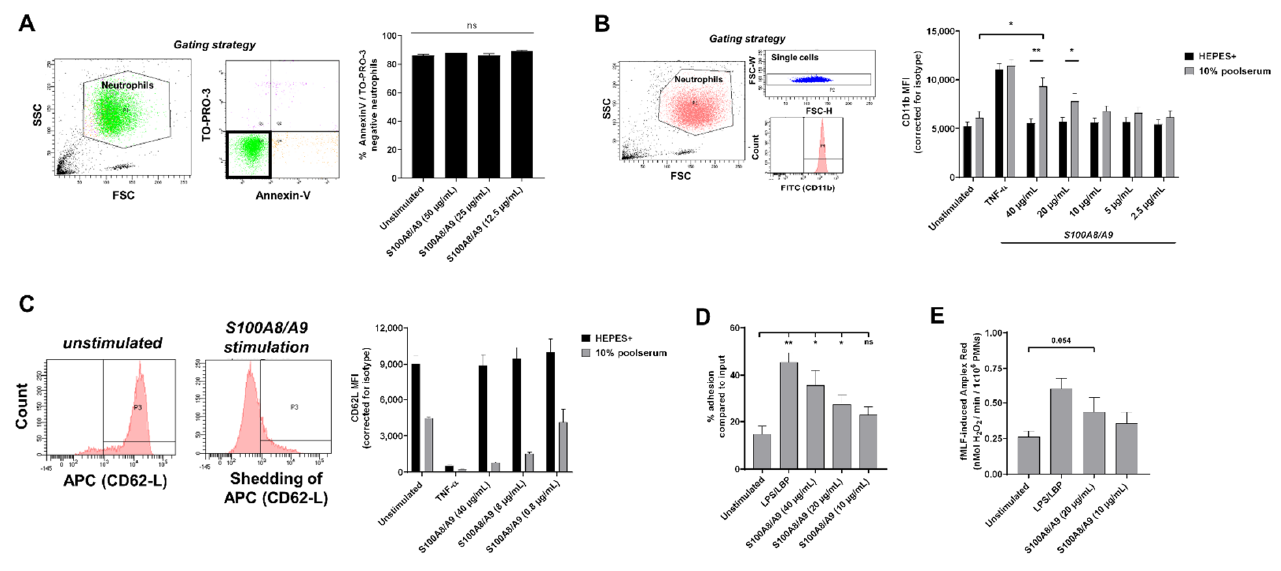
Figure 4. S100A8/A9 activates neutrophils. ( A ) Viability of neutrophils upon 2 h of incubation at 37 °C with S100A8/A9 was assessed by flow cytometry for AnnexinV and TO-PRO. Viable neutrophils were defined as negative for both markers (n = 3, mean + SEM). Indicated in the left panel is the gating strategy. ( B , C ) Expression of neutrophil activation markers ( B ) CD11b (n = 3–5, mean + SEM) and ( C ) CD62L (n = 2, mean + SEM) was measured by flow cytometry upon 2 h of incubation at 37 °C with indicated concentrations of S100A8/A9 or TNF-α in the absence or presence of 10% human serum. ( B ) Indicated in the left panel is the gating strategy. ( C ) FACS plots showing CD62-L shedding are displayed. ( D ) Neutrophils were left unstimulated or stimulated with LPS/LBP or different concentrations of S100A8/A9 for 30 min at 37 °C in the presence of 10% human serum. Percentage of adhesion is shown compared to total input (n = 3–5, mean + SEM). ( E ) Neutrophils were primed by LPS/LBP or different concentrations of S100A8/A9 in the presence of 10% human serum. After 30 min of incubation at 37 °C, 1 µM fMLF was added to induce ROS production. The maximal slope of H 2 O 2 production was measured using Amplex Red (n = 5, mean + SEM). Statistics were performed by paired t-test ( A , B , E ) or mixed effects’ model with Dunnett post hoc test ( D ); * p < 0.05, ** p < 0.01, ns = not significant.